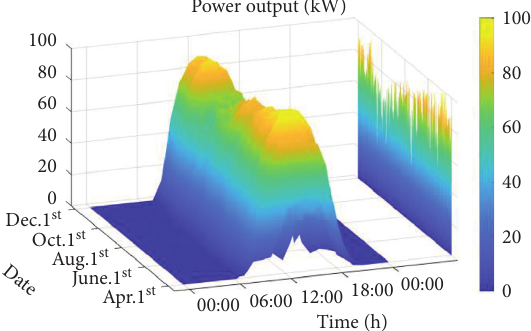
Figure 2: The output power (kW) of the PV system in the sampling time range.